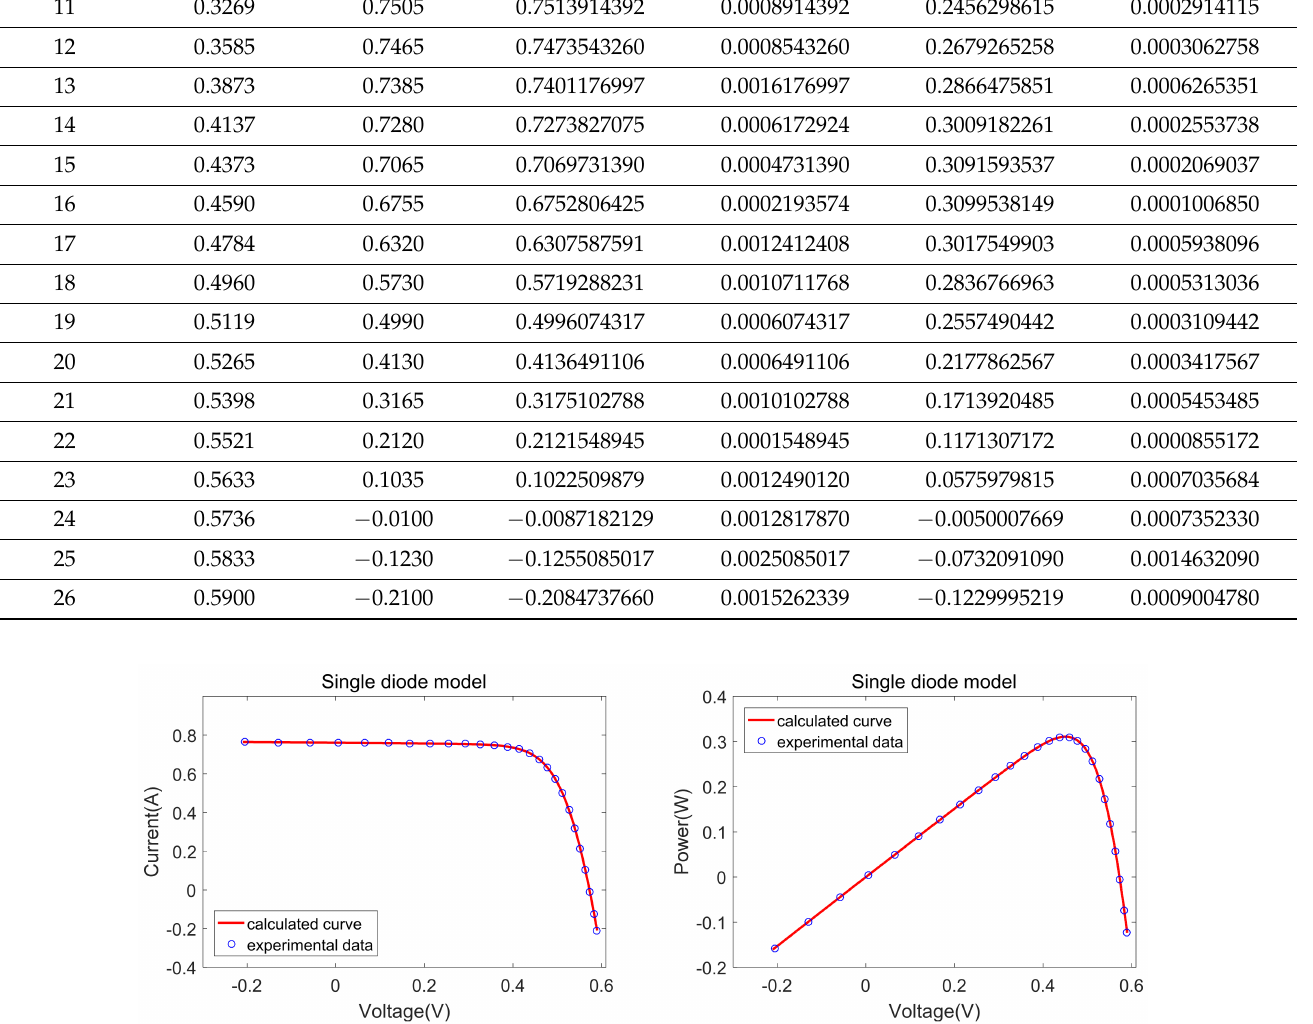
Figure 5. Experimental and calculated data of CSOOJAYA for